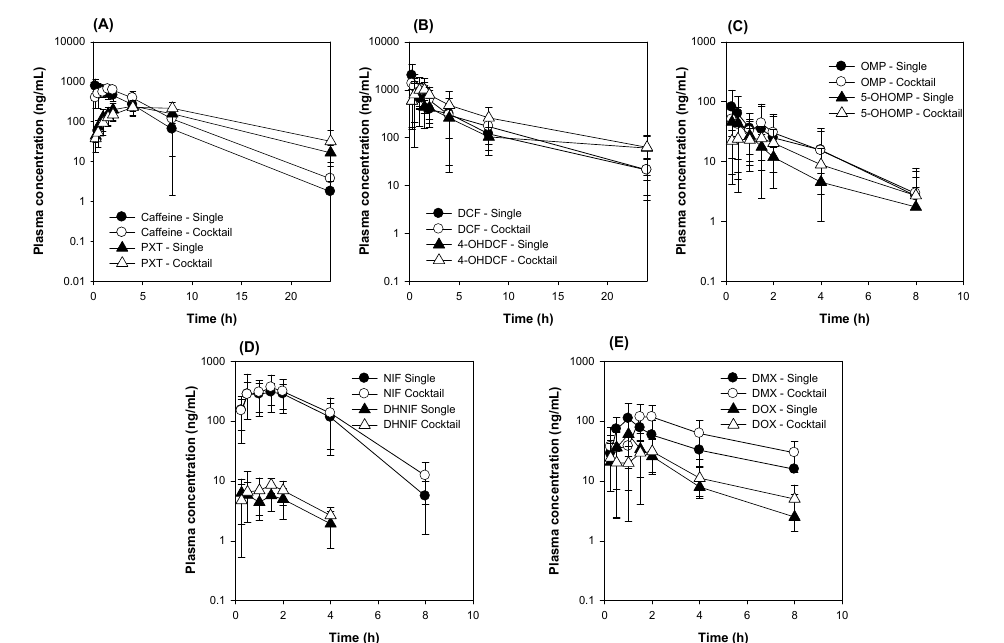
The data expressed as the mean ± standard deviation ( n = 3).